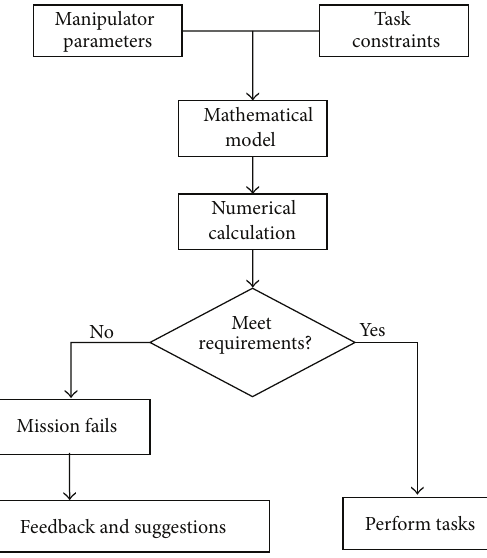
Figure 2: Analysis about whether the mission can be completed based on a specific mission and